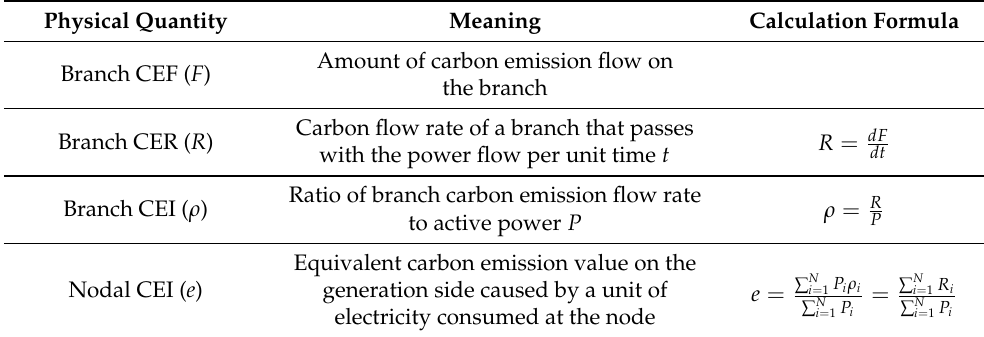
Table 2. Physical quantities of CEF